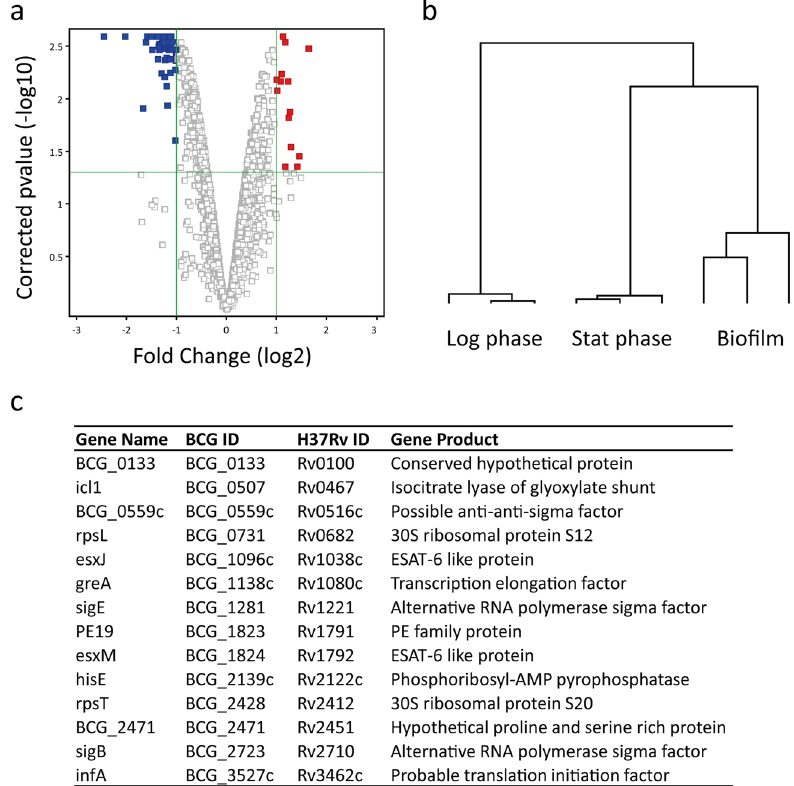
Fig. 4 Mycobacterial transcriptional response to growth as a corded bio fi lm. a Volcano plot showing transcriptional adaptations to bio fi lm growth comparing RCCS-bio fi lm to stationary phase bacilli (red, induced in bio fi lm; blue, repressed). b Dendrogram of three biological replicates of RCCS-bio fi lm alongside log phase and stationary phase controls. Hierarchical clustering of mean-centred signi fi cantly differentially expressed genes to highlight differences between RNA signatures. c Genes signi fi cantly induced by bio fi lm growth, detailing M. bovis BCG and M. tb identi fi ers. Ordered by BCG